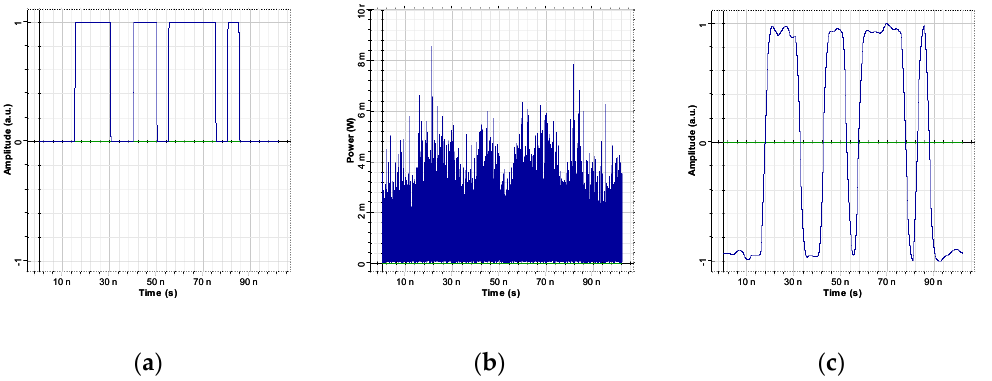
Figure 6. Time waveforms of ( a ) electrical payload sequence before optical modulation; ( b ) optical coded packets with TCK; and ( c ) demodulated payload sequence.